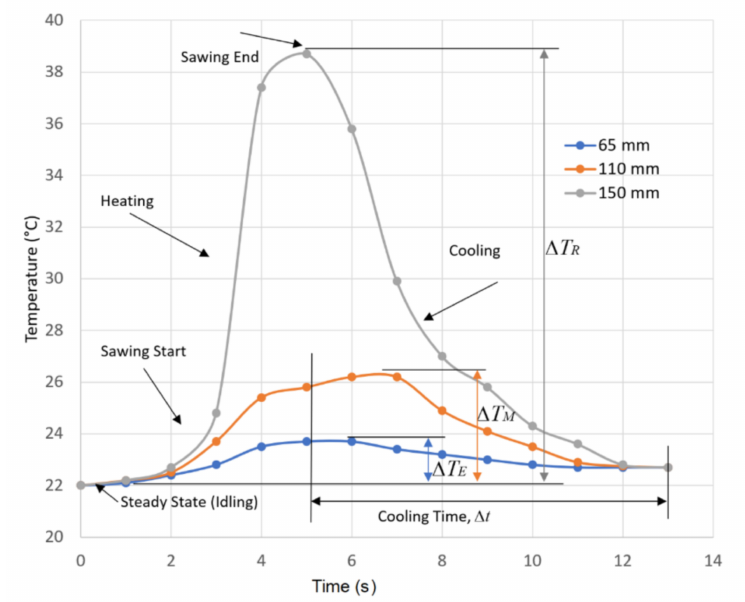
Figure 9. Experimentally measured values of CSB2 surface temperatures. (Feed speed = 21 m/min, rotation speed = 4100